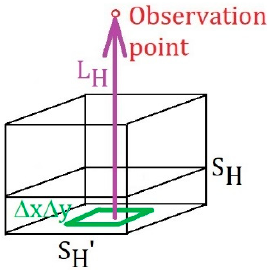
Figure 8. Simple model for light